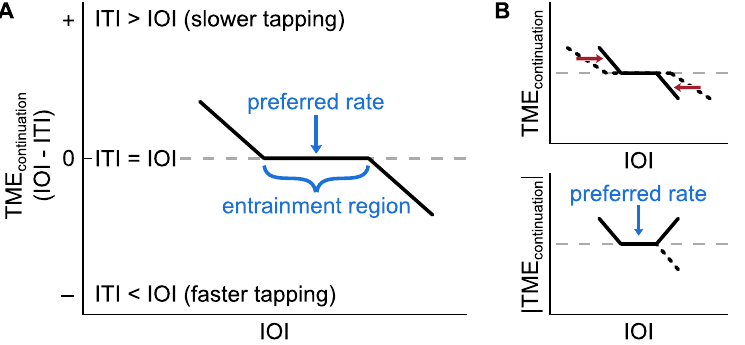
Figure 5. ( A ) “A theoretical detuning function” for an entraining oscillator, its preferred rate and the entrainment region. Adapted from Ref. 6 . At fast rates outside of the entrainment region, TME continuation is positive since tapping intervals are longer than the stimulus intervals due to drift to the preferred rate. At slow rates, the opposite is true. ( B ) An illustration of the hypothesized contraction of the entrainment region due to the ΔIOI manipulation. The lower plot illustrates how preferred rate was captured by our estimation method, curve fitting to the absolute values of TME continuation ; and that the contraction would leave preferred rate